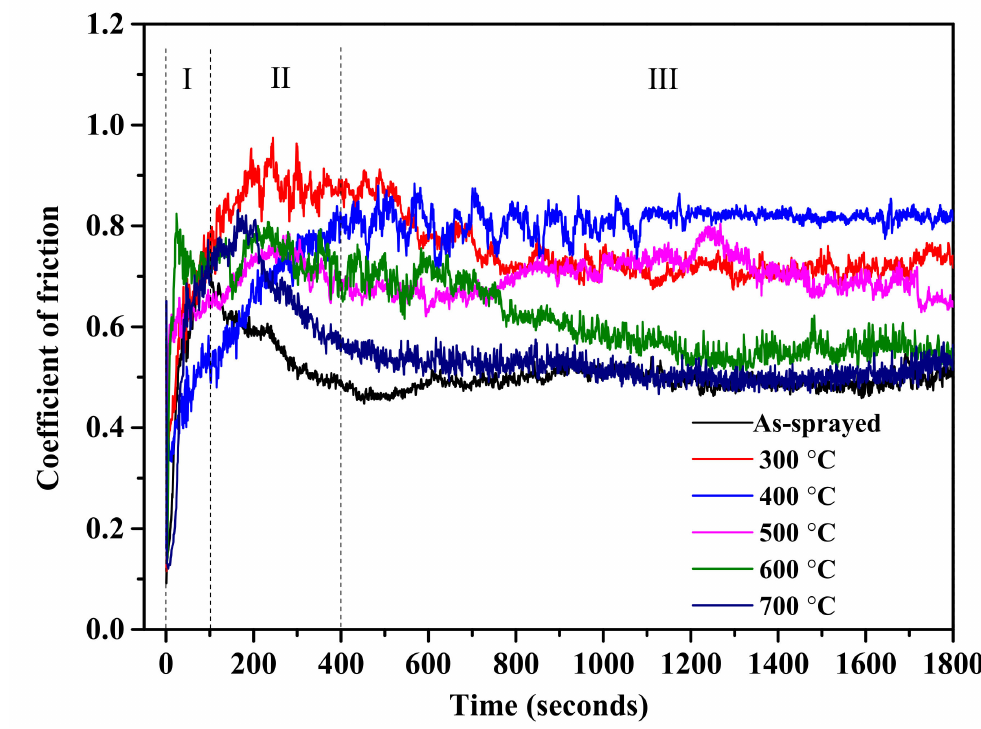
Figure 8. COF of the coatings as a function of sliding time., which shows the running-in stage (Region I), transition period (Region II) and steady-state (Region